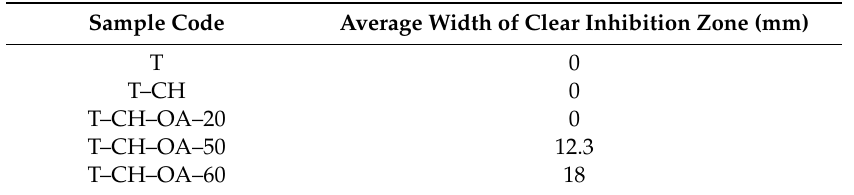
Figure 4. Digital photos of bacterial inhibition zone of ( a ) T, ( b ) T–CH and T–CH–OA–20, and ( c ) T–CH–OA–50 and T–CH–OA–60. Table 5. Antibacterial zone of untreated and treated textile